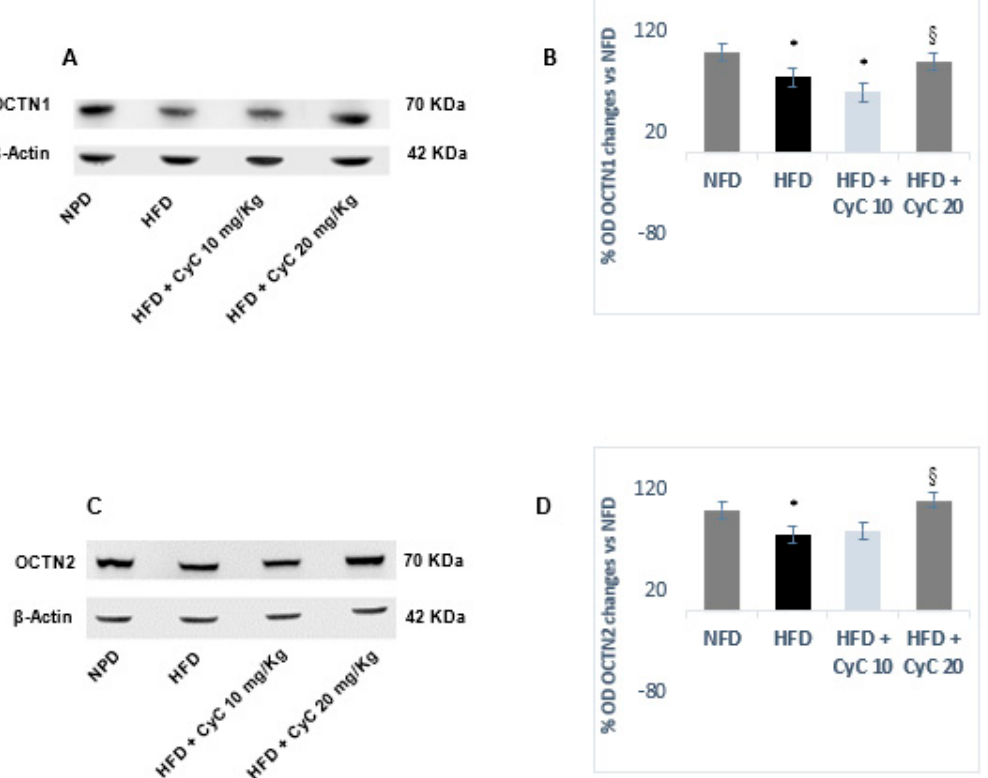
Figure 4. The effect of CyC (10 and 20 mg/kg daily given orally over a period of four weeks) on OCTN1 ( A , B ) and OCTN2 ( C , D ) carnitine-linked transporters in NFD and HFD. Representative Western blotting analysis are expressed in subgraph A and C. Optical Density for each blot is expressed in Subgraph B and D). Data are expressed as mean ± SE.* P < 0.05 HFd vs. NFD. § P < 0.05 HFD + CyC vs. HFD.